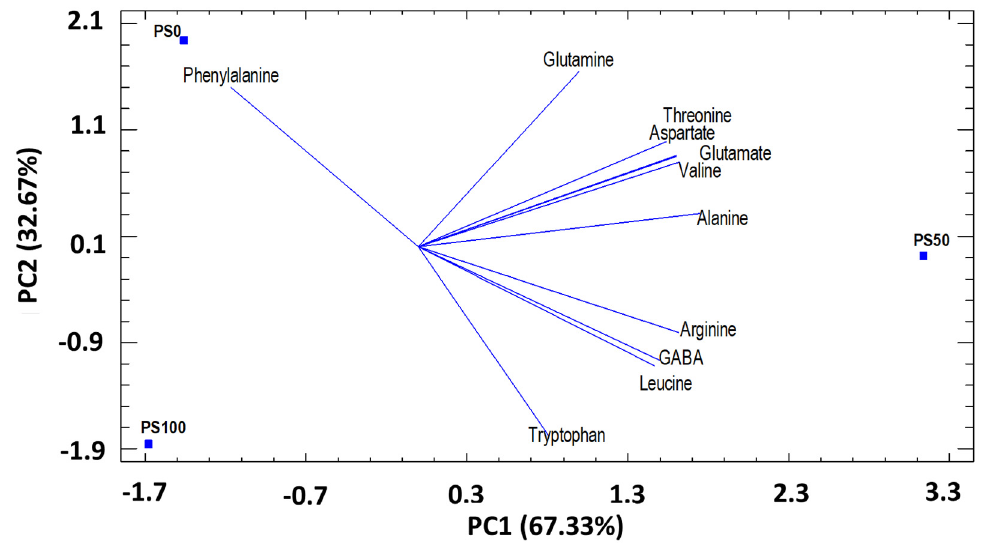
Figure 1. Principal components analysis (PC1 and PC2) for amino acids identified in pomegranate leaves cultivated in three different substrates. PC1 (67.33%) and PC2 (32.67%). Sugars and Organic Acids